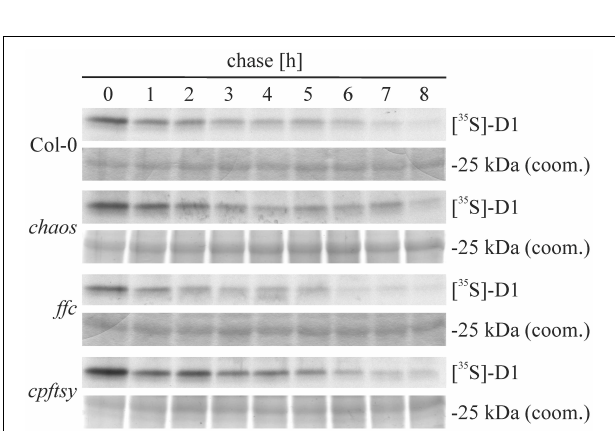
FIGURE 7 | Pulse and chase labeling of thylakoid membrane proteins. Tylakoid membrane proteins were radiolabeled with [ 35 S]-methionine in leaf discs of wild type and cpSRP mutants in presence of cycloheximide. After a pulse of 60min, the protein turnover was chased for up to 8h. Every hour, a sample was taken and thylakoid membrane proteins were extracted, subjected to SDS-PAGE, coomassie stained and visualized by autoradiography.